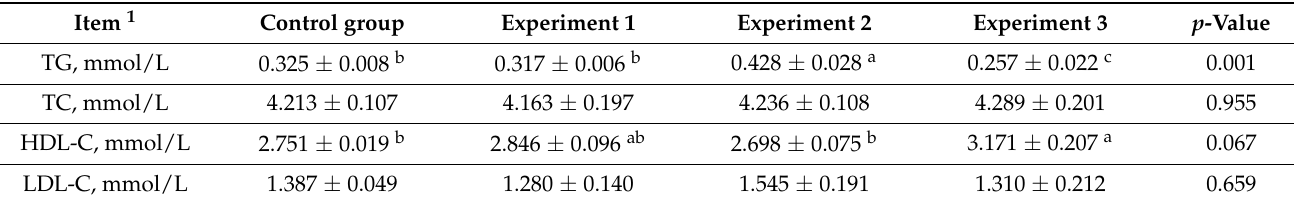
Table 4. Blood lipid indexes of